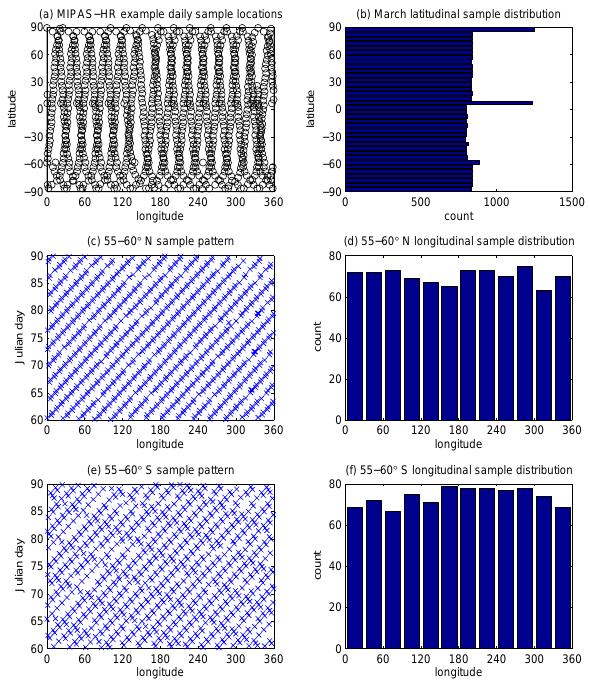
Fig. 1. MIPAS-HR March sampling, approximating MIPAS sam- pling over the time interval July 2002 to March 2004. (a) Example daily sampling spatial pattern, (b) monthly sample counts per 5 ◦ latitude bin, (c) time, longitude pattern of samples and (d) zonal sample distribution for the 55–60 ◦ N latitude bin, (e) time, longi- tude pattern of samples and (f) zonal sample distribution for the 55–60 ◦ S latitude